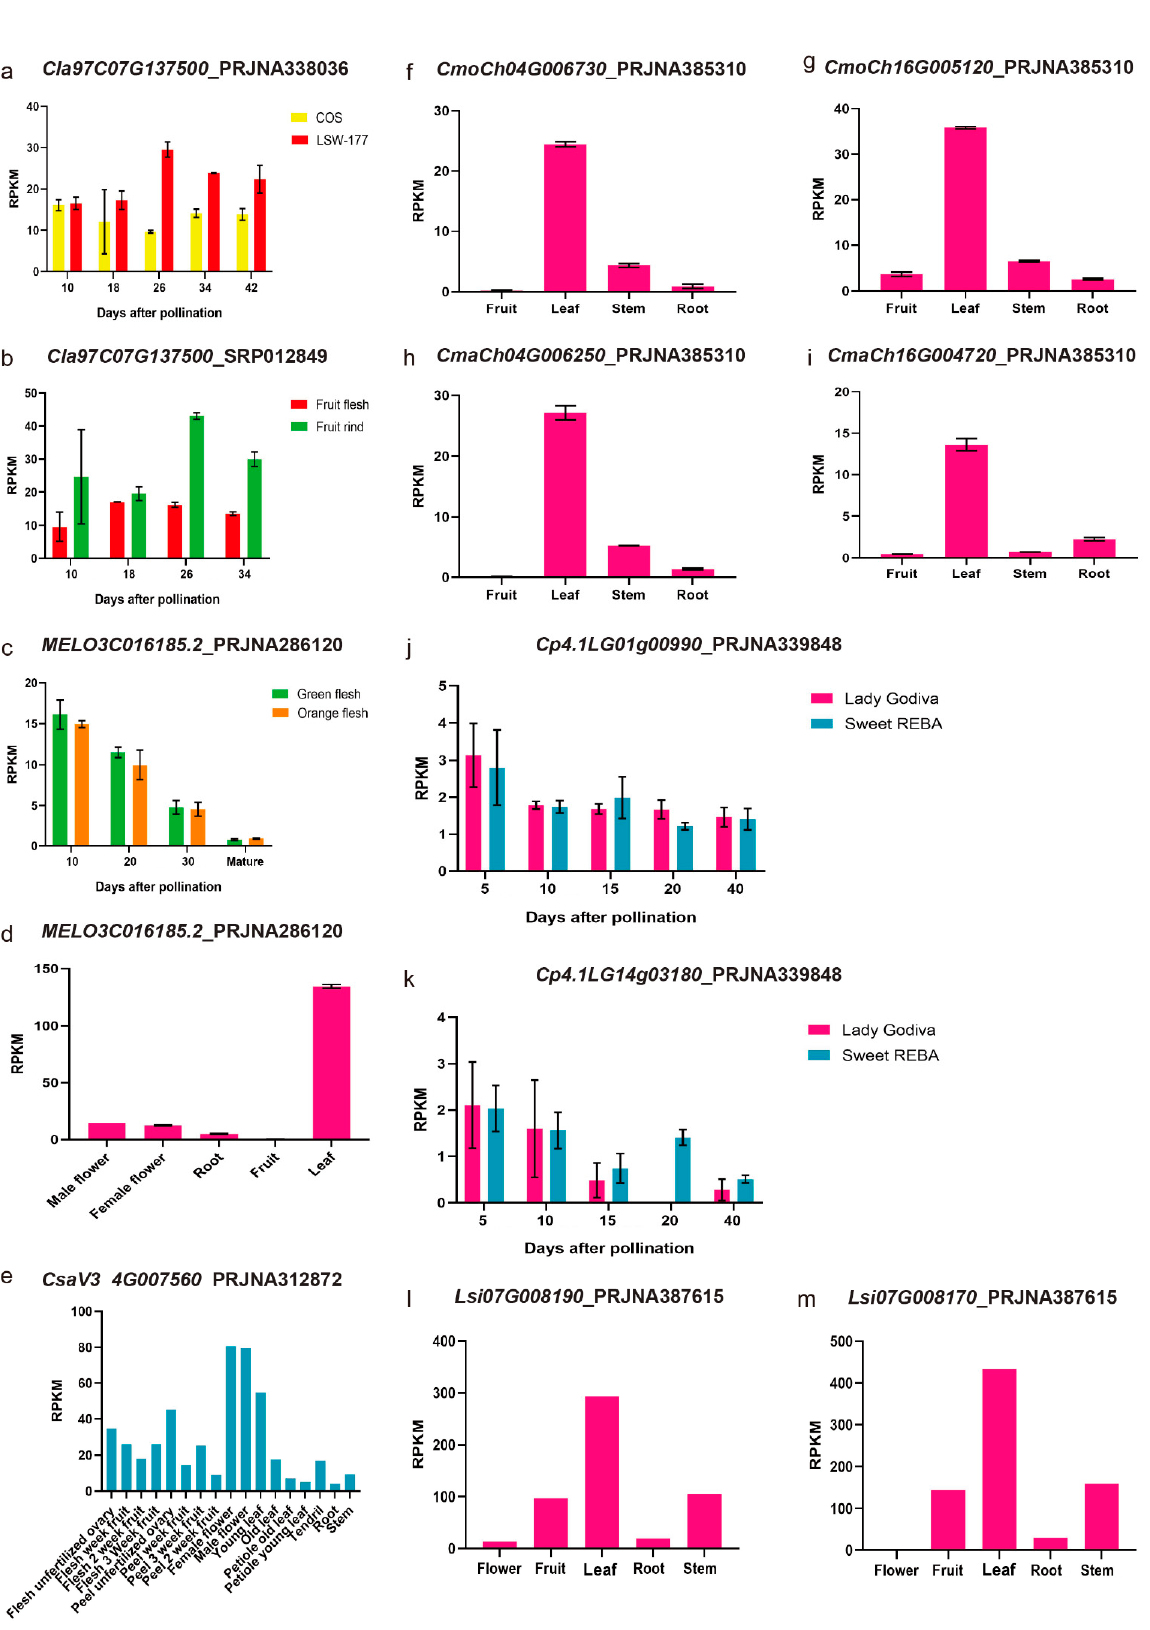
Figure 9. ClPSY3 homologous genes expression pattern analysis with the published RNA-seq data. ( a – m ): RPKM of PRJNA338036, SPR012849, PRJNA286120, PRJNA312872, PRJNA385310, PRJNA339848 and